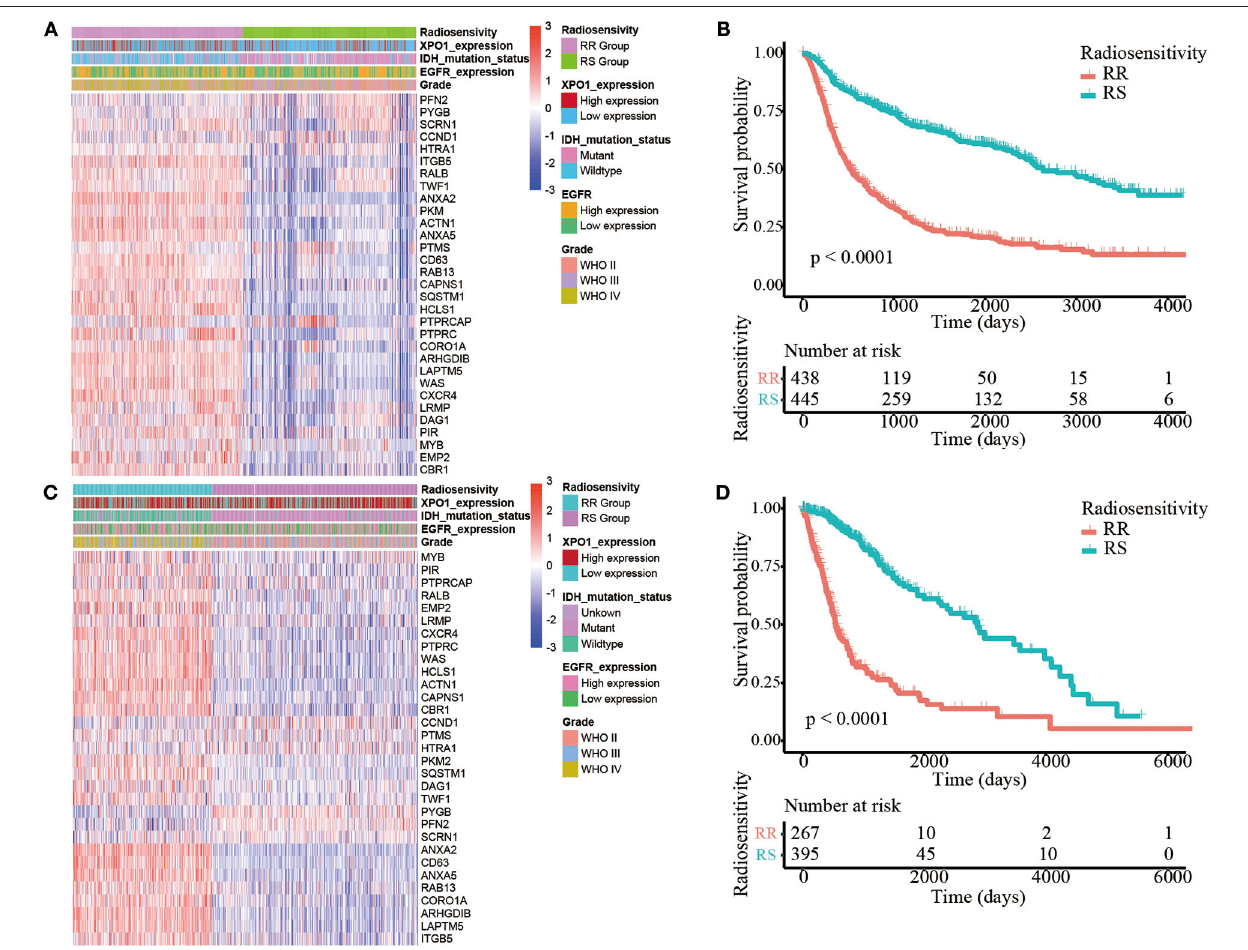
FIGURE 1 | Identification of the radiosensitive (RS) and radioresistant (RR) groups. (A) A heatmap illustrating the 31-gene signature, XPO1 expression, ERGF expression, IDH mutation status, and WHO classification in every sample from the CGGA cohort. Columns represent samples and rows represent gene expression and clinical characters. (B) Differences in OS between the two clusters in the CGGA cohort. The cluster with more satisfactory OS was defined as the RS group ( P < 0.0001). (C) A heatmap illustrating the 31-gene signature, XPO1 expression, ERGF expression, IDH mutation status, and WHO classification in every sample from the TCGA cohort. (D) Differences in OS between the two clusters in the TCGA cohort. The cluster with more satisfactory OS was defined as the RS group ( P <